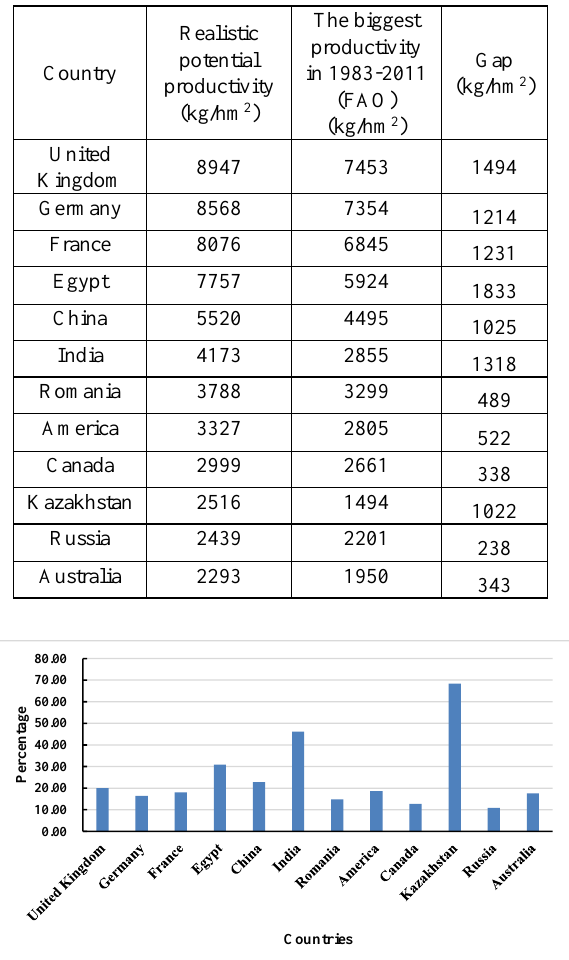
Figure 4. Distribution of the winter wheat realistic potential productivity in the world. Table 1 The statistic of the realistic potential productivity of winter wheat in the main winter wheat producing countries